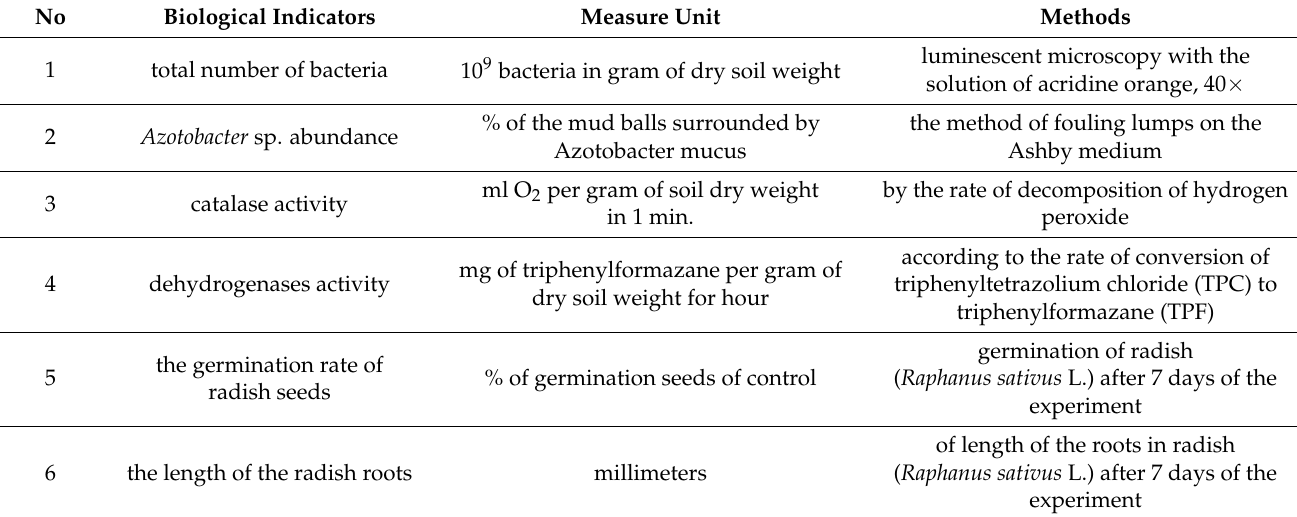
Table 1. Characteristics of biological indicators of Cambisols’